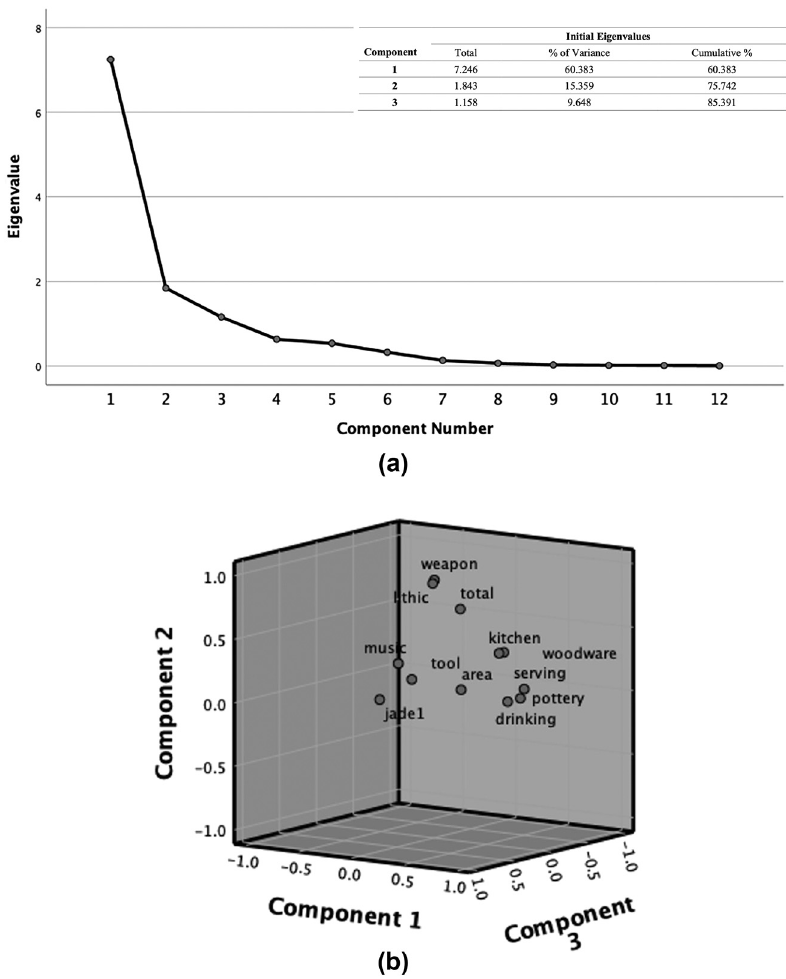
Figure 2: ( a ) The eigenvalues of factor analysis and ( b ) the component plot in rotated space.